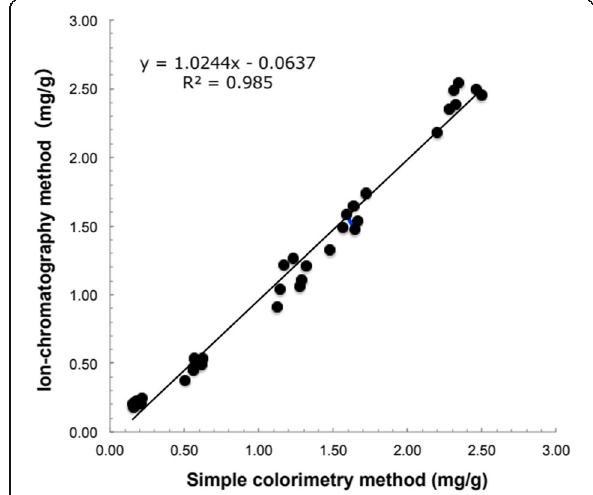
Fig. 2 Comparison of the colorimetric method and ion chromatography for determining the ammonia levels in tobacco filler